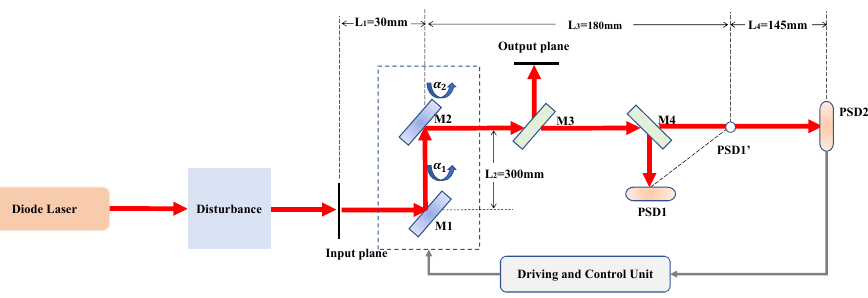
Figure 1. Schematic of the beam pointing control system. M1, Mirror 1; PSD, Position Sensitive